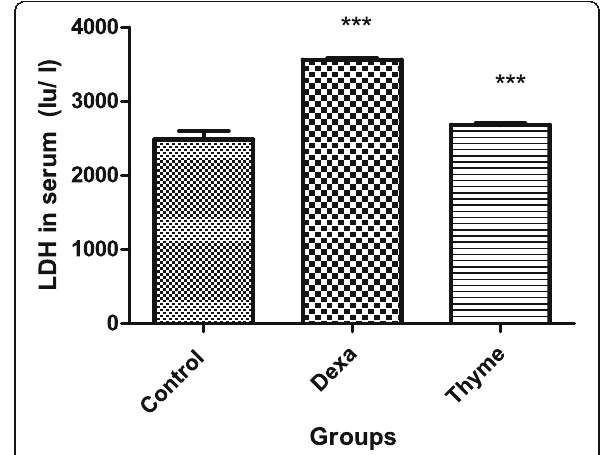
Fig. 2 The defensive role of thyme aqueous extract on serum aspartate aminotransferase (AST) activity in normal and dexamethasone (DXM)-treated rats. Percentage changes (%) were calculated by comparing normal group with DXM-treated group and pre-treated DXM groups with DXM-treated group